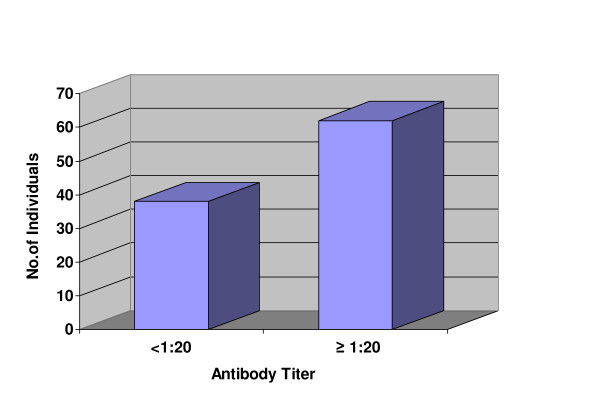
Proportions of samples with antibody titers < 1:20 vs. ≥ 1:20 (N = 100).